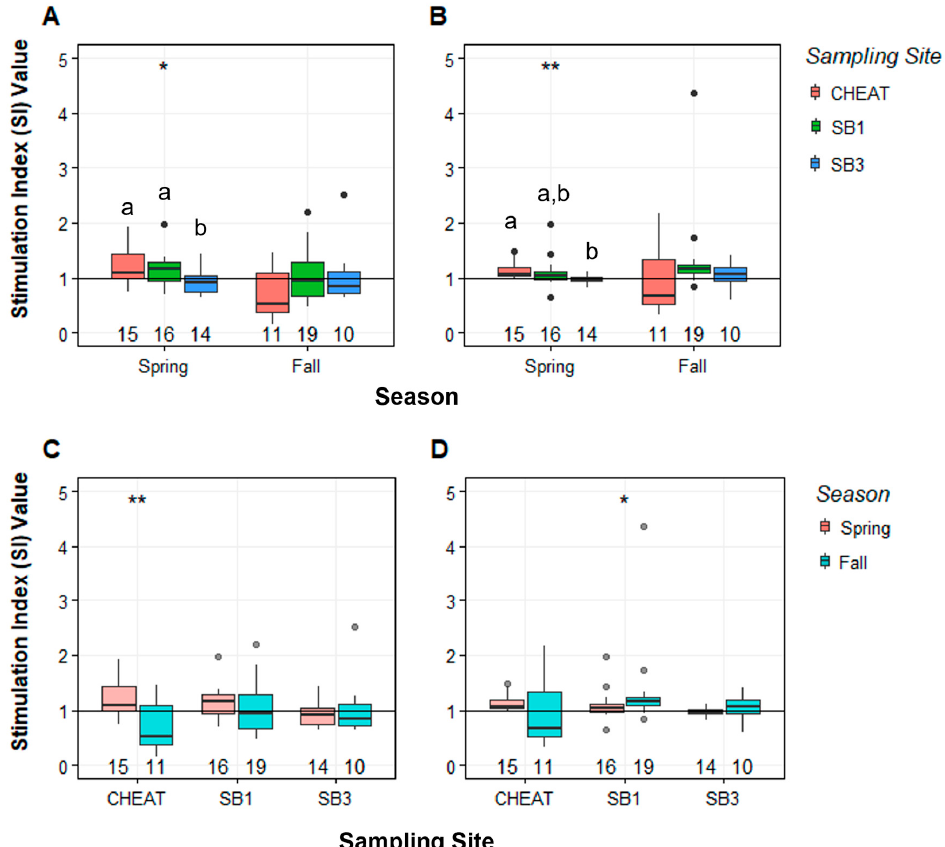
Figure 4. Stimulation indices (SI) for IgM+ (left column) and IgM − (right column) lymphocytes isolated from anterior kidney of smallmouth bass ( Micropterus dolomieu ) collected at the Cheat River (CH), South Branch Potomac near Petersburg (SB1), and South Branch Potomac near Moorefield (SB3), West Virginia after exposure to LPS. Site comparisons ( A , B ) were made using Dunn’s Kruskal–Wallis multiple comparison test, and p -values were adjusted with the Holm method. Seasonal comparisons ( C , D ) were made using Wilcoxon rank-sum test. Asterisks indicate significant differences between groups (* = p < 0.05, ** = p < 0.01). Superscripts represent significant differences between sites. The horizontal line at 1 indicates the stimulation index (SI) threshold, the dots represent outlying data points (>1.5 times the interquartile range), and the number at 0 indicates sample size (n). Median (line in box) and interquartile range (box) are displayed with the vertical lines indicating highest and lowest values within 1.5 times above and below the interquartile